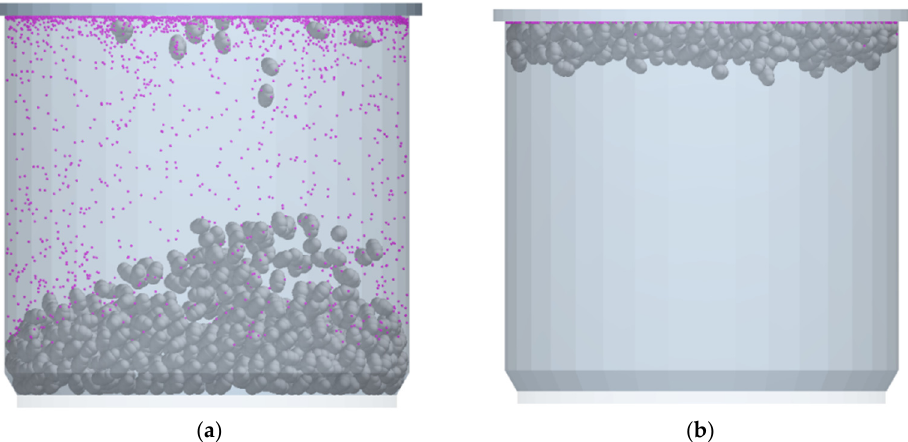
Figure 7. Material particle position transient map. ( a ) When the air velocity is 2 m/s, two material particles are suspended; ( b ) when the air velocity is 8 m/s, two types of material particles are suspended.